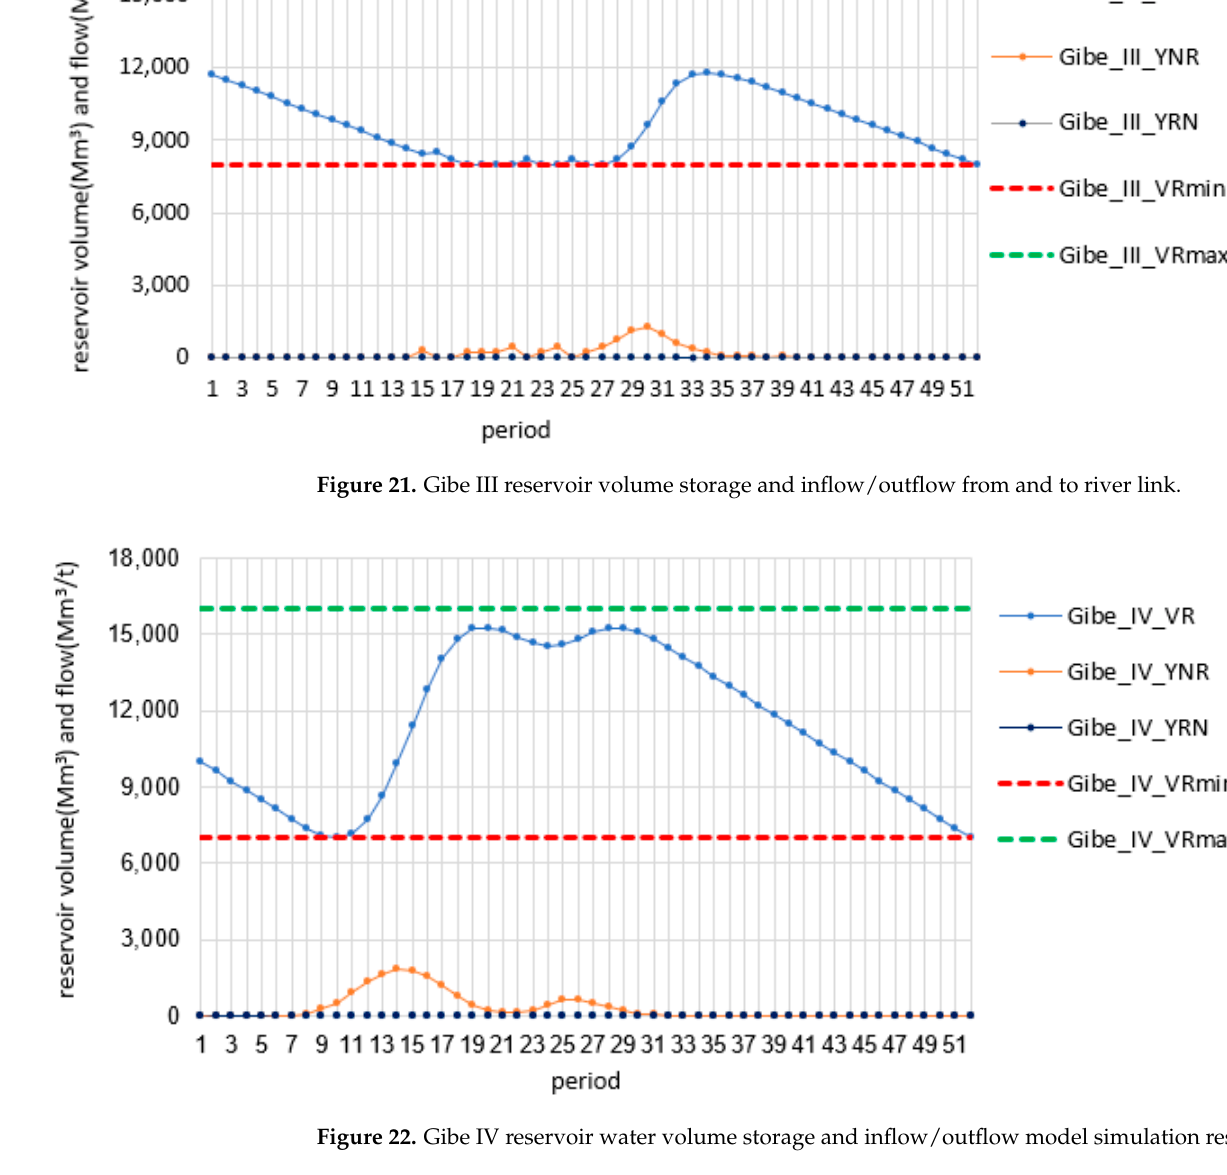
Figure 22. Gibe IV reservoir water volume storage and inflow/outflow model simulation results.